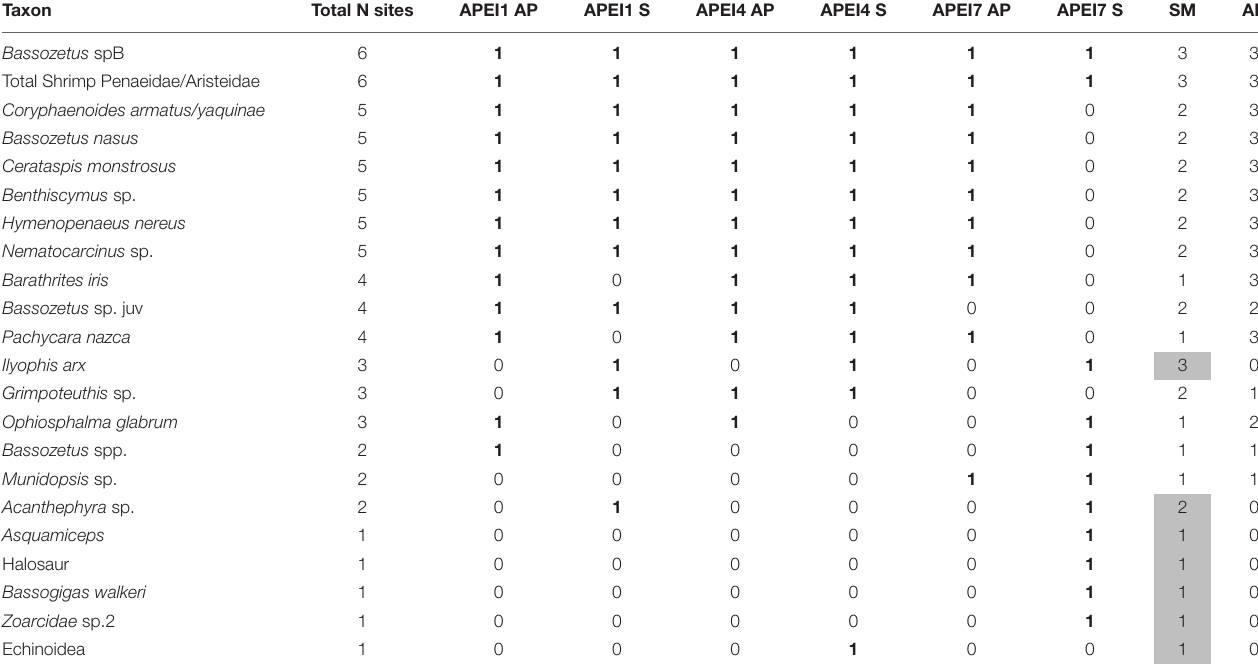
TABLE 4 | Presence table for each bait-attending taxon in order of most widely